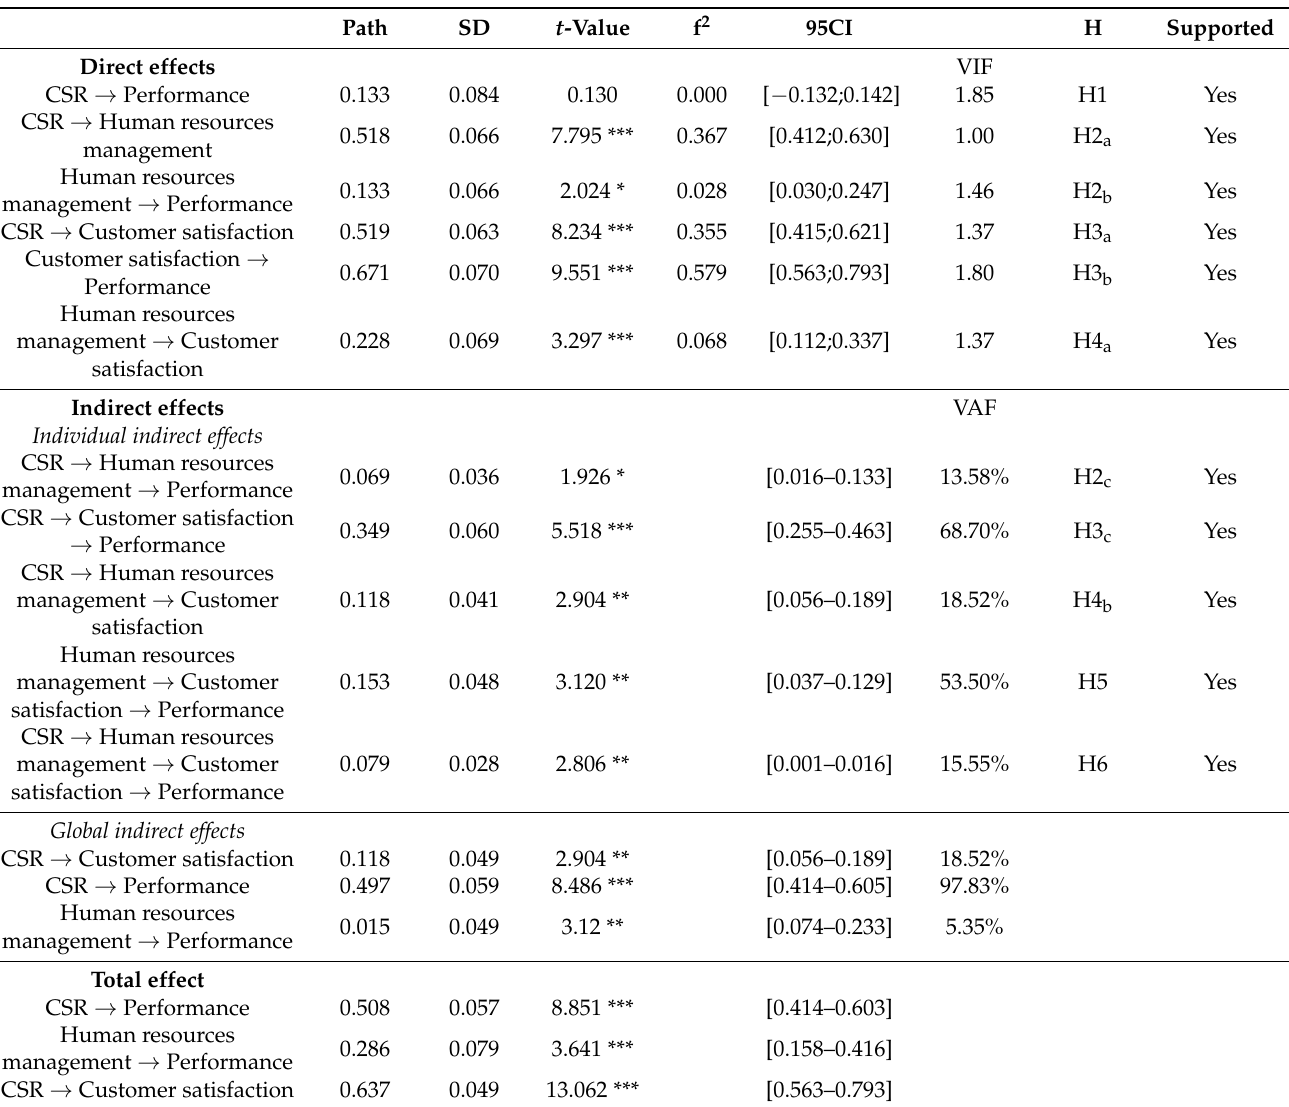
Table 4. Structural model and hypotheses